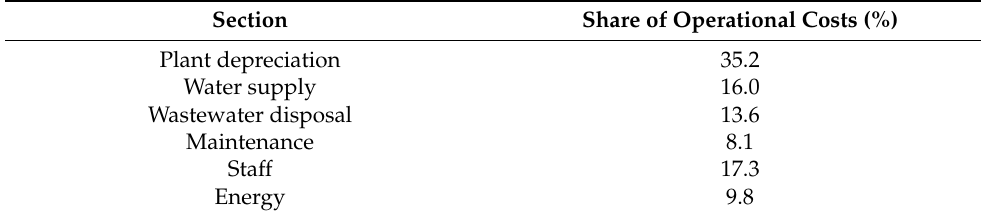
Table 18. Operational expenditure per section.